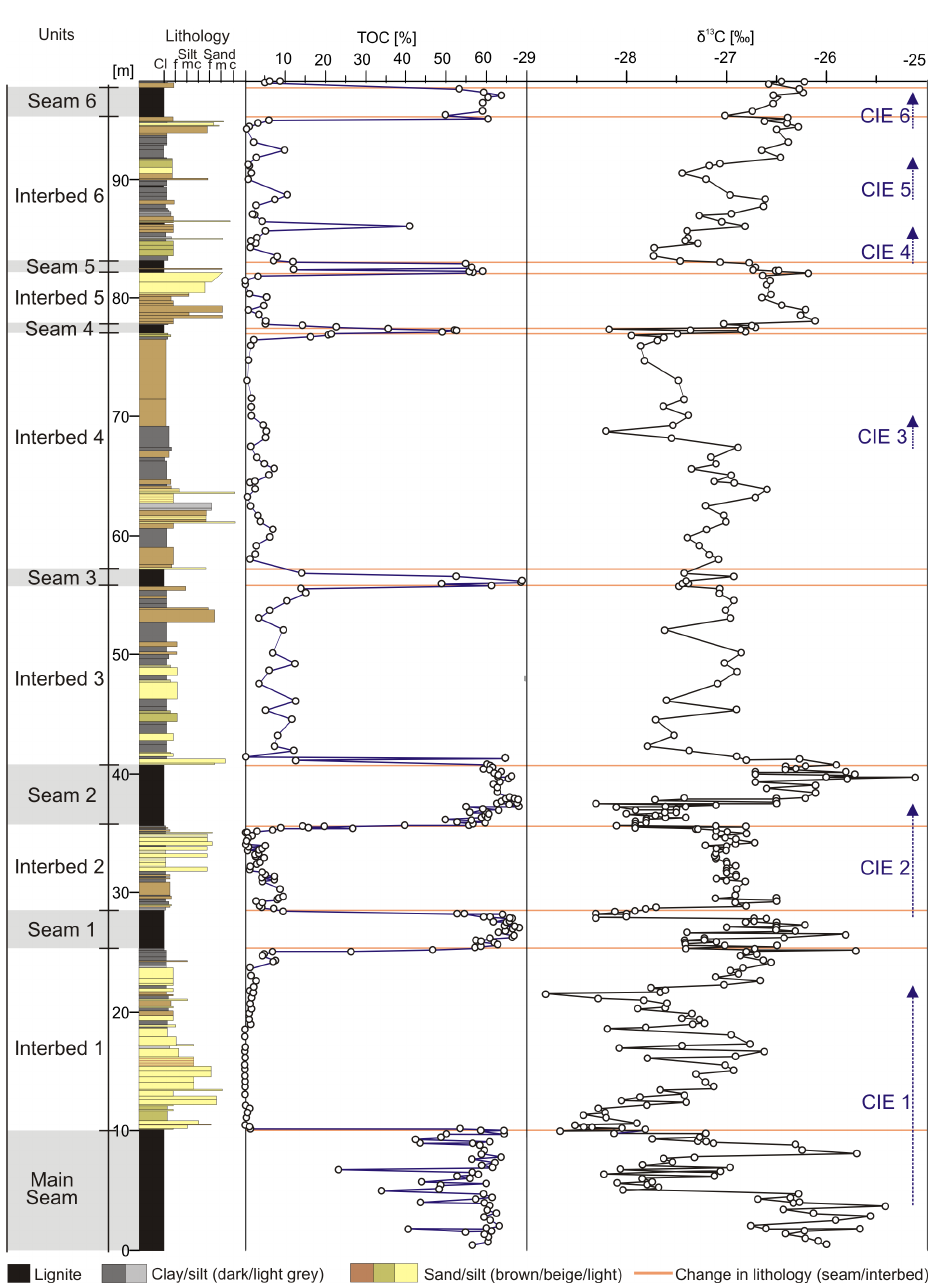
Figure 4. Composite stratigraphic section of the lower part of the Schöningen Formation from the Main Seam to the base of Interbed 7 with total organic carbon (%TOC) and δ 13 C TOC values of bulk organic matter. Lines denote lithological changes between brackish interbeds and lignite seams. Six identified CIEs are